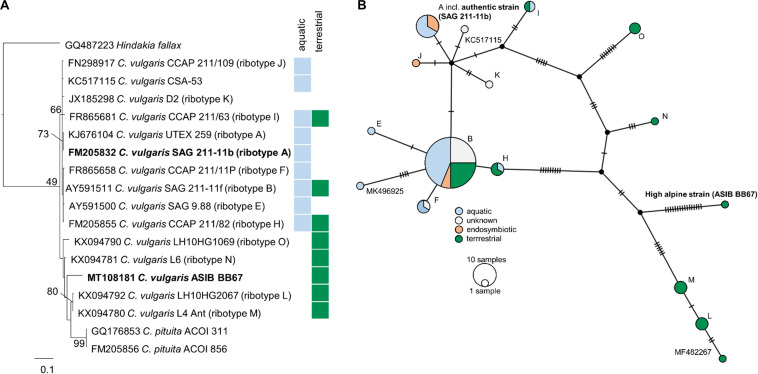
Molecular phylogeny and ribotype network of Chlorella vulgaris. (A) Molecular phylogeny of ITS2 sequence comparisons of Chlorella vulgaris. (B) Ribotype network (TCS calculated by PopArt) of 83 Chlorella vulgaris ITS sequences. Each hatch marks one mutation. Ribotype assignment was conducted according to Hodač et al. (2016); sequences not yet assigned to a ribotype are indicated by their accession numbers. Colors indicate habitats (blue: aquatic; green: terrestrial) or symbiotic life-style (orange) of the strains.